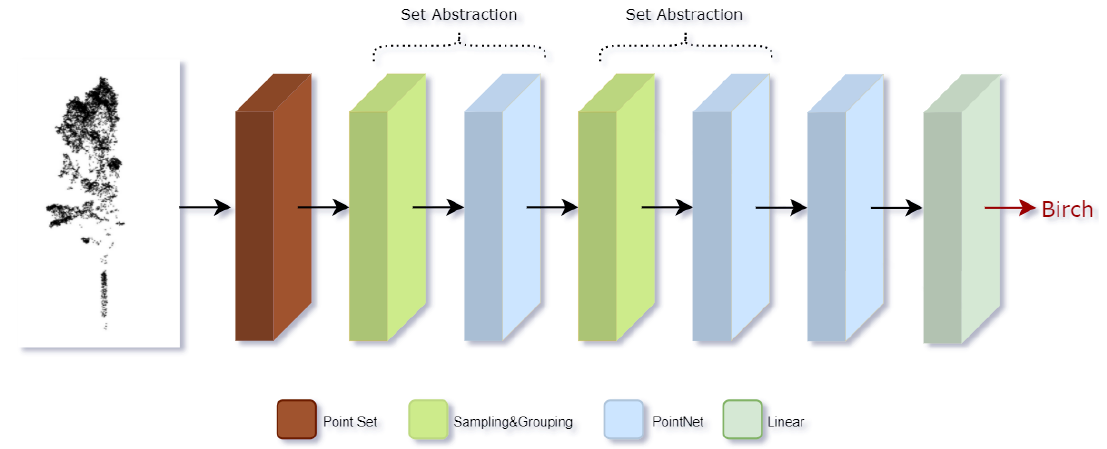
Figure 10. The classification section of structure of